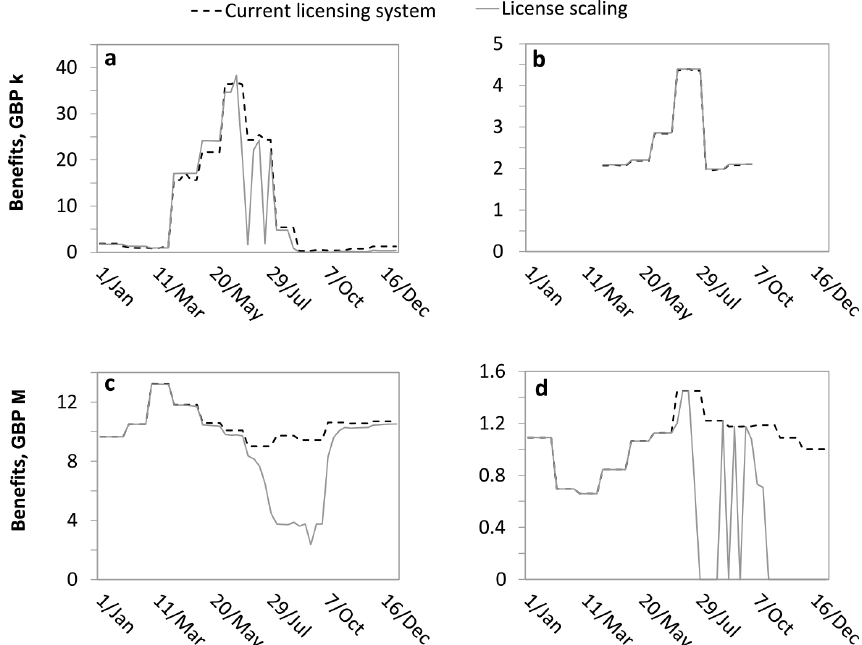
Figure 9. Comparison of gross economic benefits by sector from water use under the current and proposed licensing systems acting in conjunction with a short-term water market. The results are aggregated by sector: (a) agriculture; (b) industry; (c) water supply; (d) energy. The top panels show benefits in thousands of pounds and the bottom one in